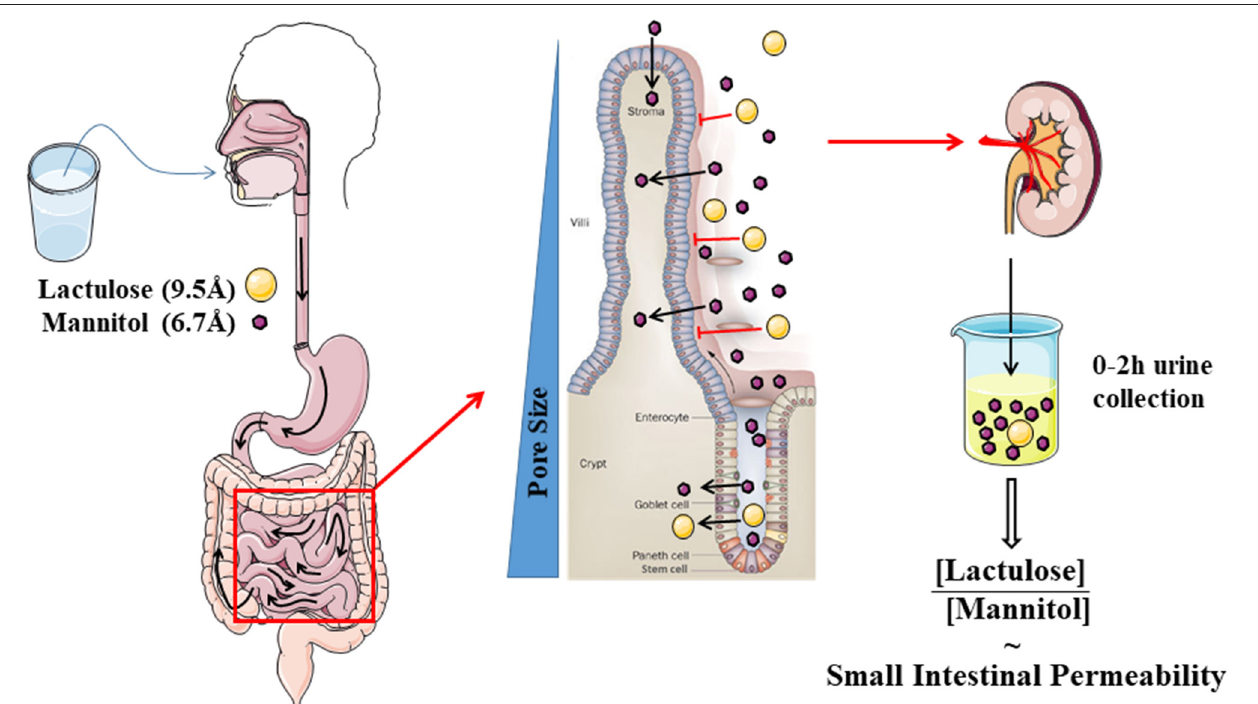
FIGURE 2 | Schematic cartoon of the evaluation of small intestinal permeability by using the lactulose- mannitol test. recovery of mannitol is 100-fold higher than lactulose, which cannot be sufficiently explained by the size difference